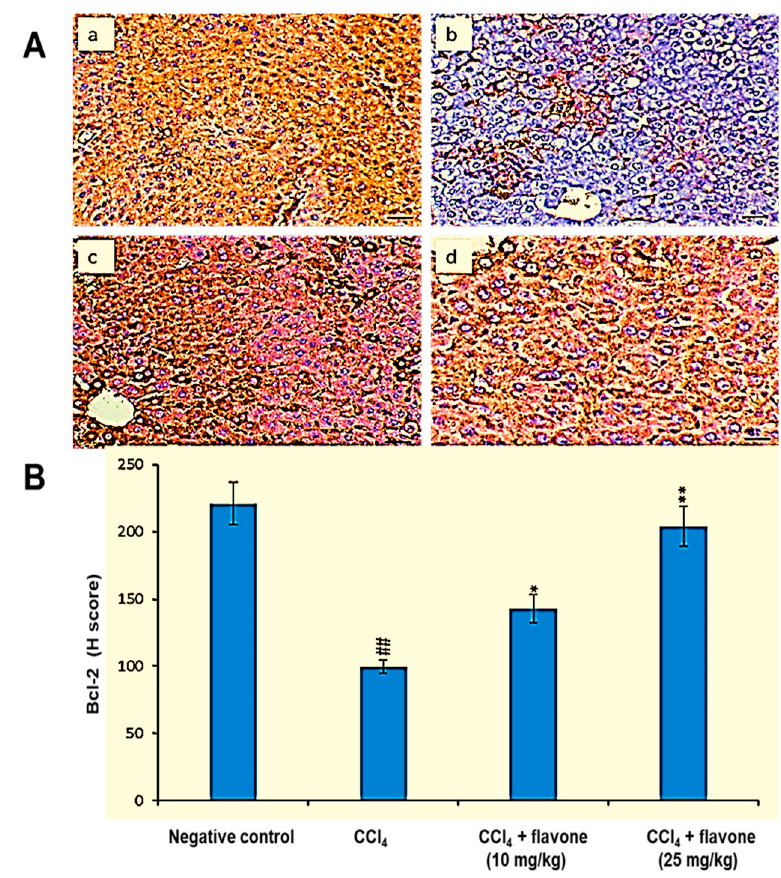
Figure6. E ff ectoftreatmentwiththeflavoneontheBcl-2proteinlevelinlivertissues. ( A ):Representative liver immunohistochemical graphs (a: negative control group, b: carbon tetrachloride (CCl 4 ) group, c: CCl 4 + flavone (10 mg / kg) group, d: CCl 4 + flavone (25 mg / kg) group); ( a ) showed a noticeable expression of bcl-2 immunostaining in the liver tissues (arrow). ( b ) presented marked decrease in Bcl-2 expression within the liver tissues (arrow). ( c ) displayed mild to moderate increase of Bcl-2 expression in the liver tissues (arrow). ( d ) illustrated an obvious increase in Bcl-2 expression within the liver tissues (arrow). Scale bar = 100 µ m. ( B ): Statistical analysis of Bcl-2 H-score. Data are expressed as mean ± SD. Significantly ( ## p < 0.01) di ff erent to negative control group. Significantly (* p < 0.05 and